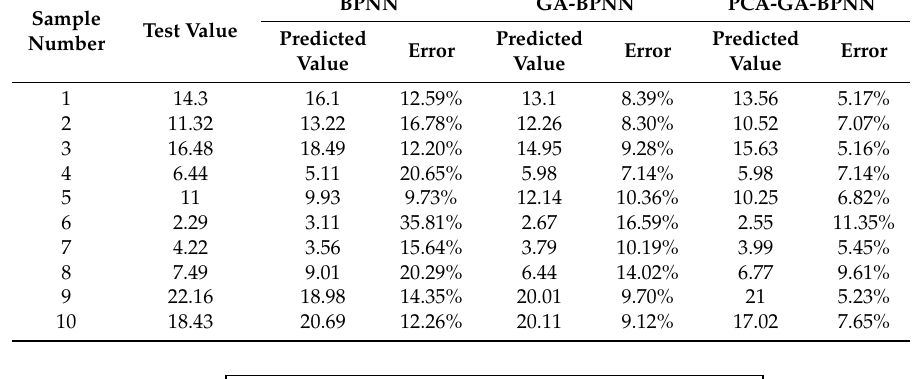
Table 1. Prediction results of water content. Table 1. prediction results of water content.